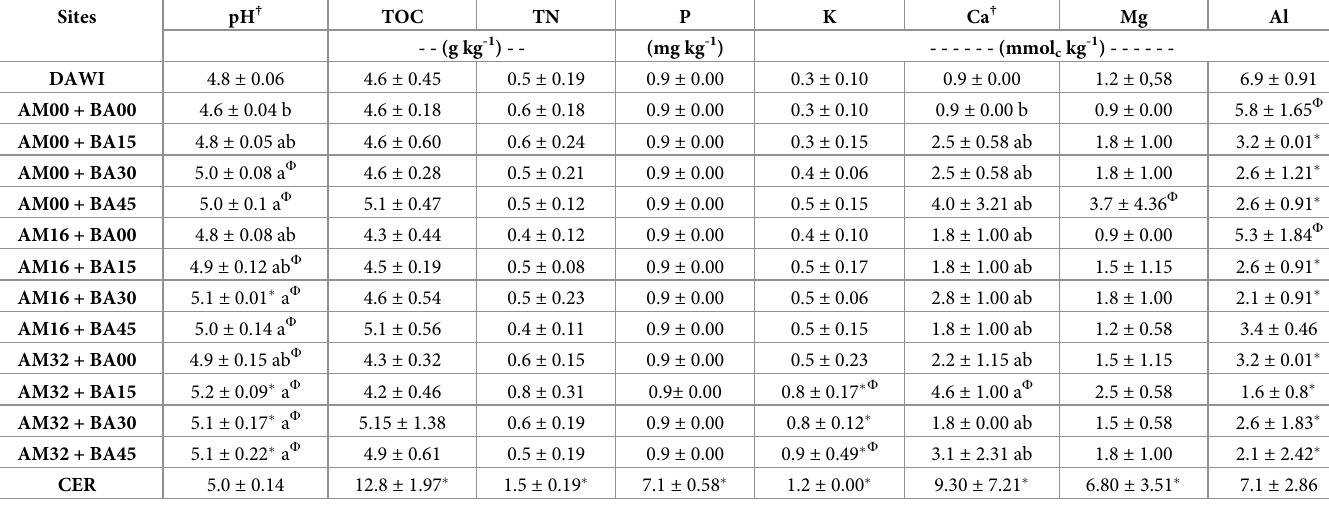
� = Mean values with asterisks are significantly different from control (DAWI) by the Dunnett test (p < 0.05). † Significant interaction effect between AM and BA amendments. Means followed by the same letter, in the columns do not differ significantly by Tukey test (p < 0.05). F Not significantly different than undisturbed Cerrado (CER) AM = aquatic macrophytes applied at 0, 16, and 32 t ha -1